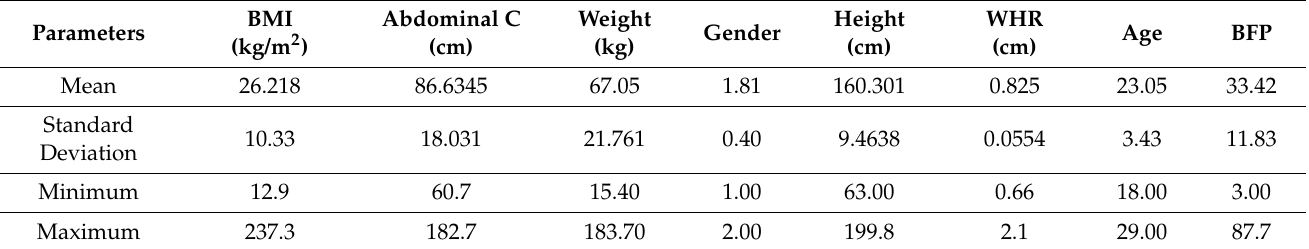
Table 1. Descriptive statistics of the dataset.